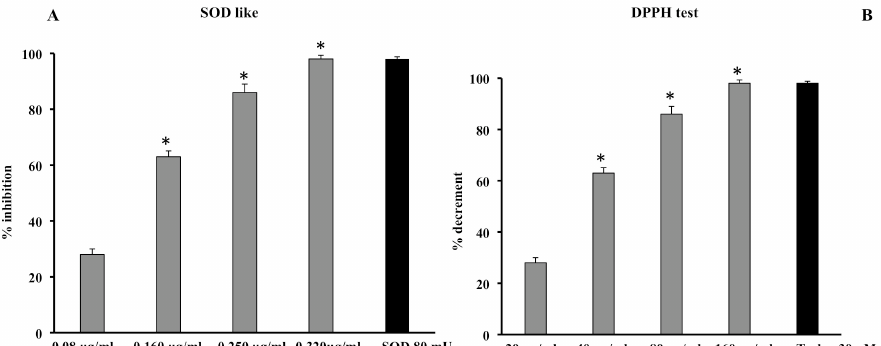
Figure 4. Scavenger effect of C. sinensis extract by SOD-like ( A ) and DPPH assay ( B ). Superoxide anion results ( A ) are expressed as percentage of inhibition of NADH oxidation (rate of superoxide anion production was 4 nmol/min). Quenching effect ( B ) results are expressed as percentage of the decrease in absorbance at λ = 517 nm when compared with the control. Each value represents the mean ± S.D. of three independent experiments in triplicate. * Significant vs. p < 0.001 vs. previous